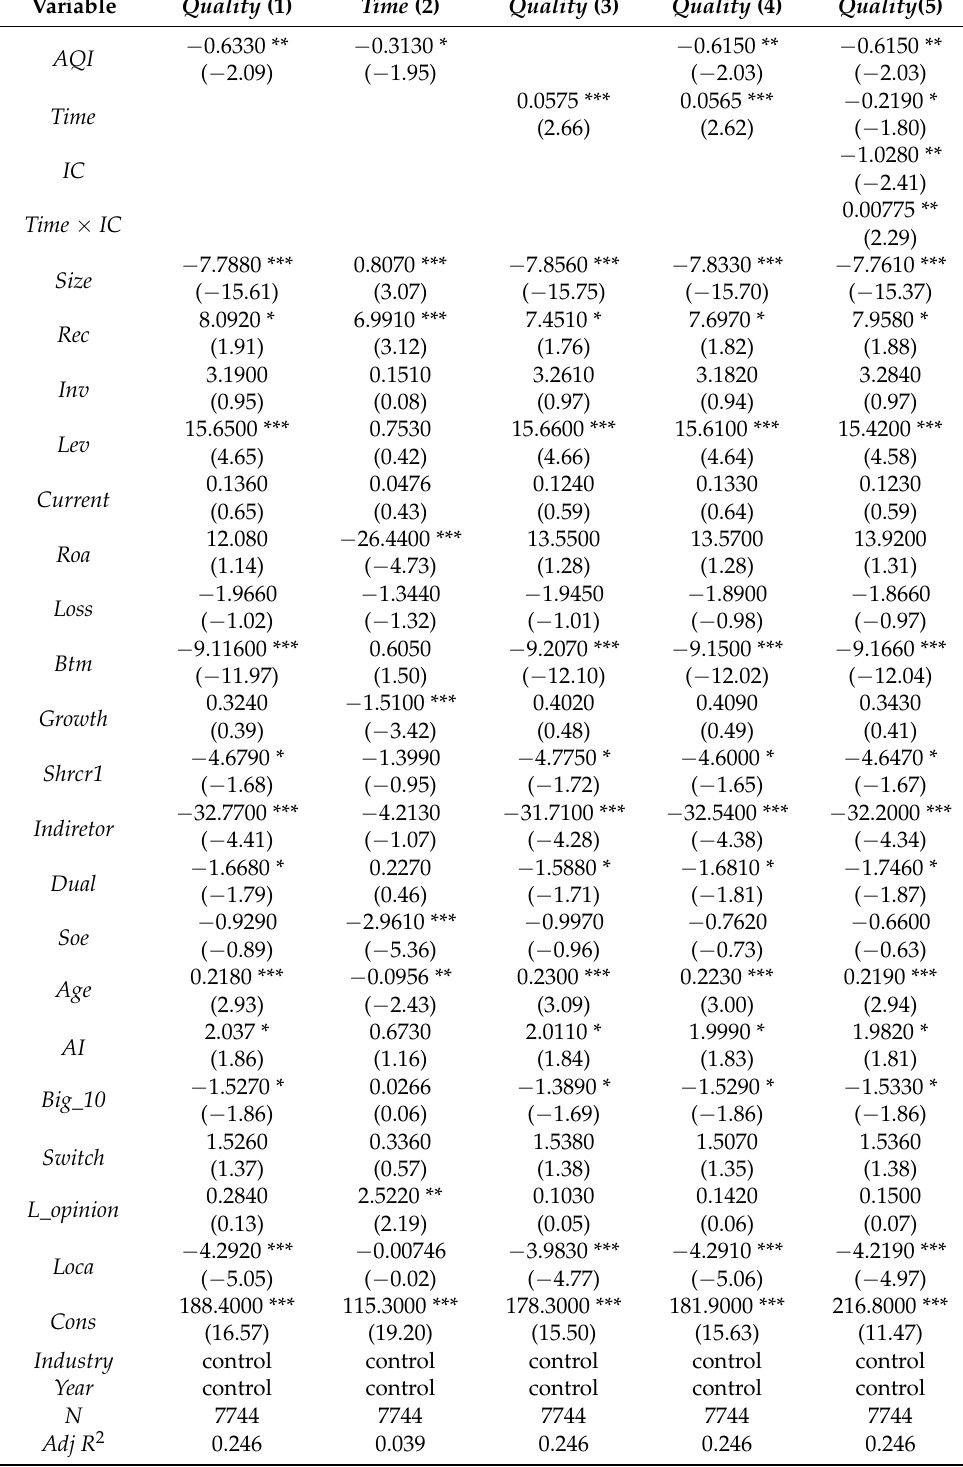
Table 6. Regression results using AQI